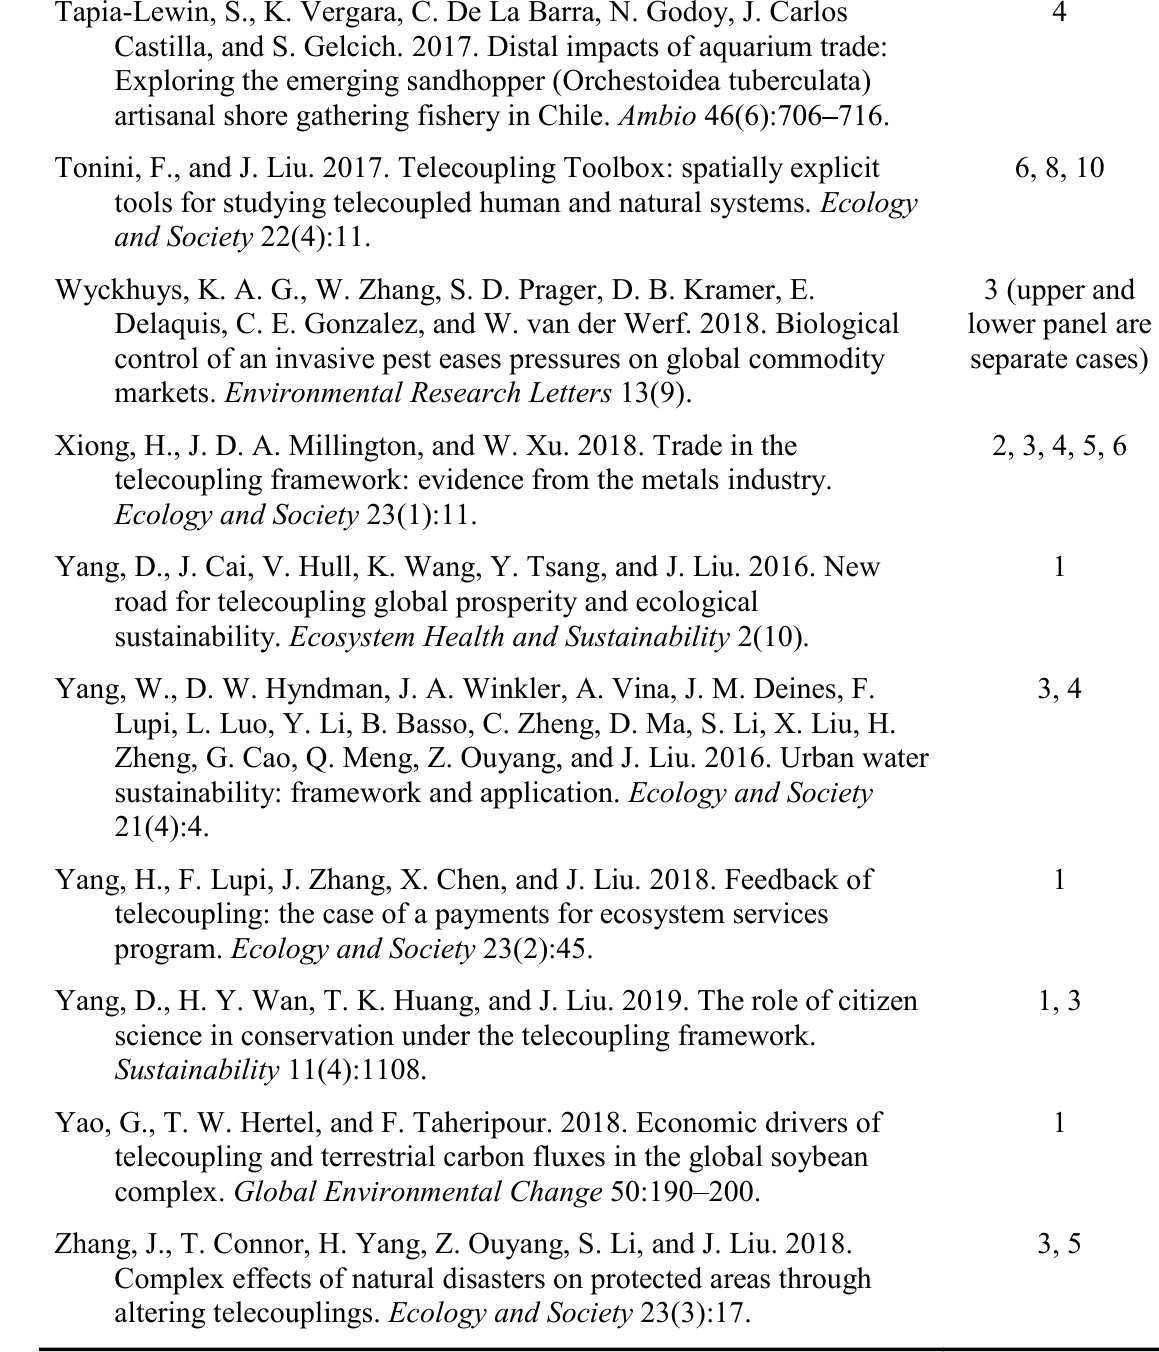
Table A1.1 . List of selected